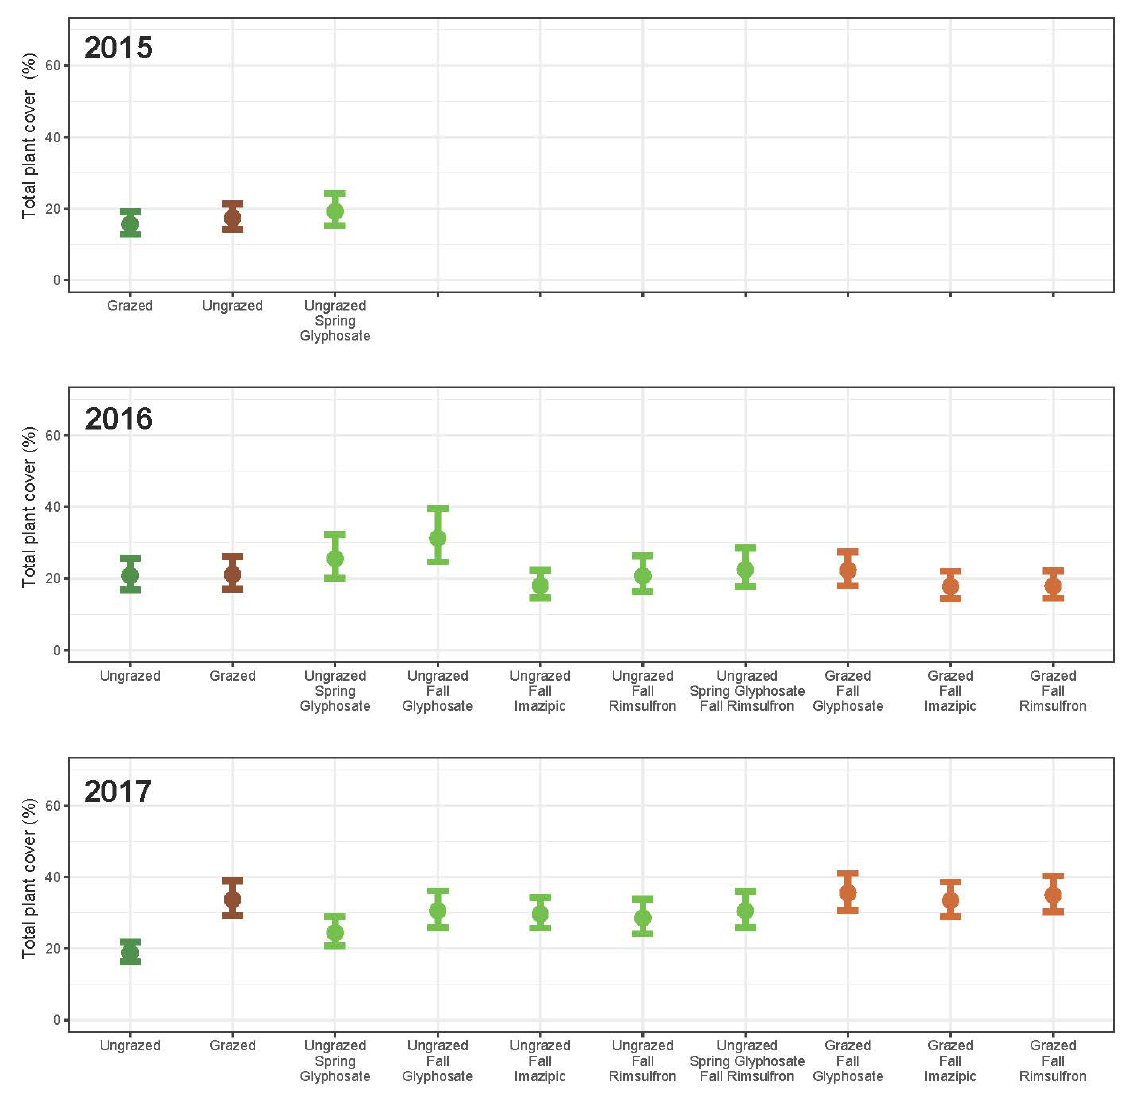
Figure 4. Fitted model results for total plant cover (excluding Bromus tectorum ; %; mean ± SE) response to grazing, herbicide, and integrated treatments at Red Blu ff , Montana in 2015, 2016, and 2017. Fall herbicide treatments were implemented after summer data collection in 2015, so these treatments do not show results in 2015. Furthermore, fall herbicide results in 2016 and 2017 represent treatments implemented in the prior years. Data shown are predicted values from linear mixed e ff ects models, and thus the means are not identical to means from the raw